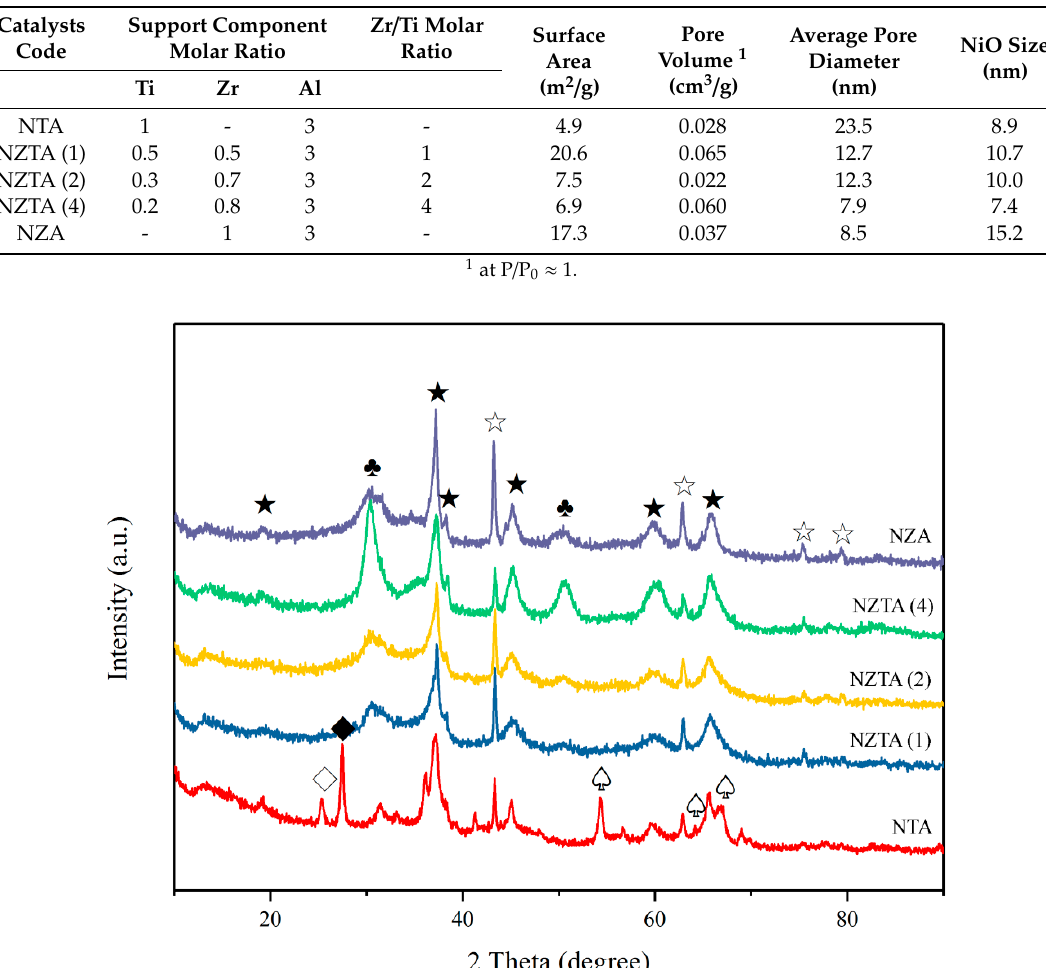
Figure 1. XRD pattern of the prepared catalysts calcined at 800 °C; ( ★ NiAl 2 O 4 ☆ NiO ♣ t-ZrO 2 ◇ TiO 2 anatase ◆ TiO 2 rutile ♤ NiTiO 3 ).